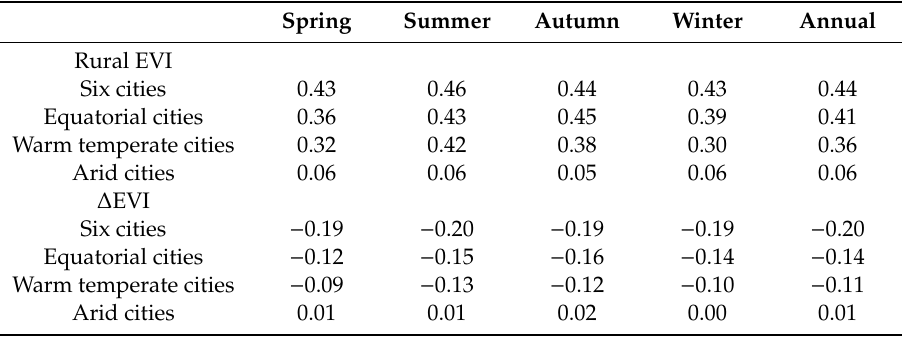
Table 6. The average rural EVI and ∆ EVI for the six high-SUHII cities and the other 38 cities, in di ff erent climate zones. The six cities are Medell í n (Colombia), Manaus (Brazil), S ã o Paulo (Brazil), Cali (Colombia), Quito (Ecuador) and Bogot á (Colombia). Spring Summer Autumn Winter Annual Rural EVI Six cities 0.43 0.46 0.44 0.43 0.44 Equatorial cities 0.36 0.43 0.45 0.39 0.41 Warm temperate cities 0.32 0.42 0.38 0.30 0.36 Arid cities 0.06 0.06 0.05 0.06 0.06 ∆ EVI Six cities − 0.19 − 0.20 − 0.19 − 0.19 − 0.20 Equatorial cities − 0.12 − 0.15 − 0.16 − 0.14 − 0.14 Warm temperate cities − 0.09 − 0.13 − 0.12 − 0.10 − 0.11 Arid cities 0.01 0.01 0.02 0.00